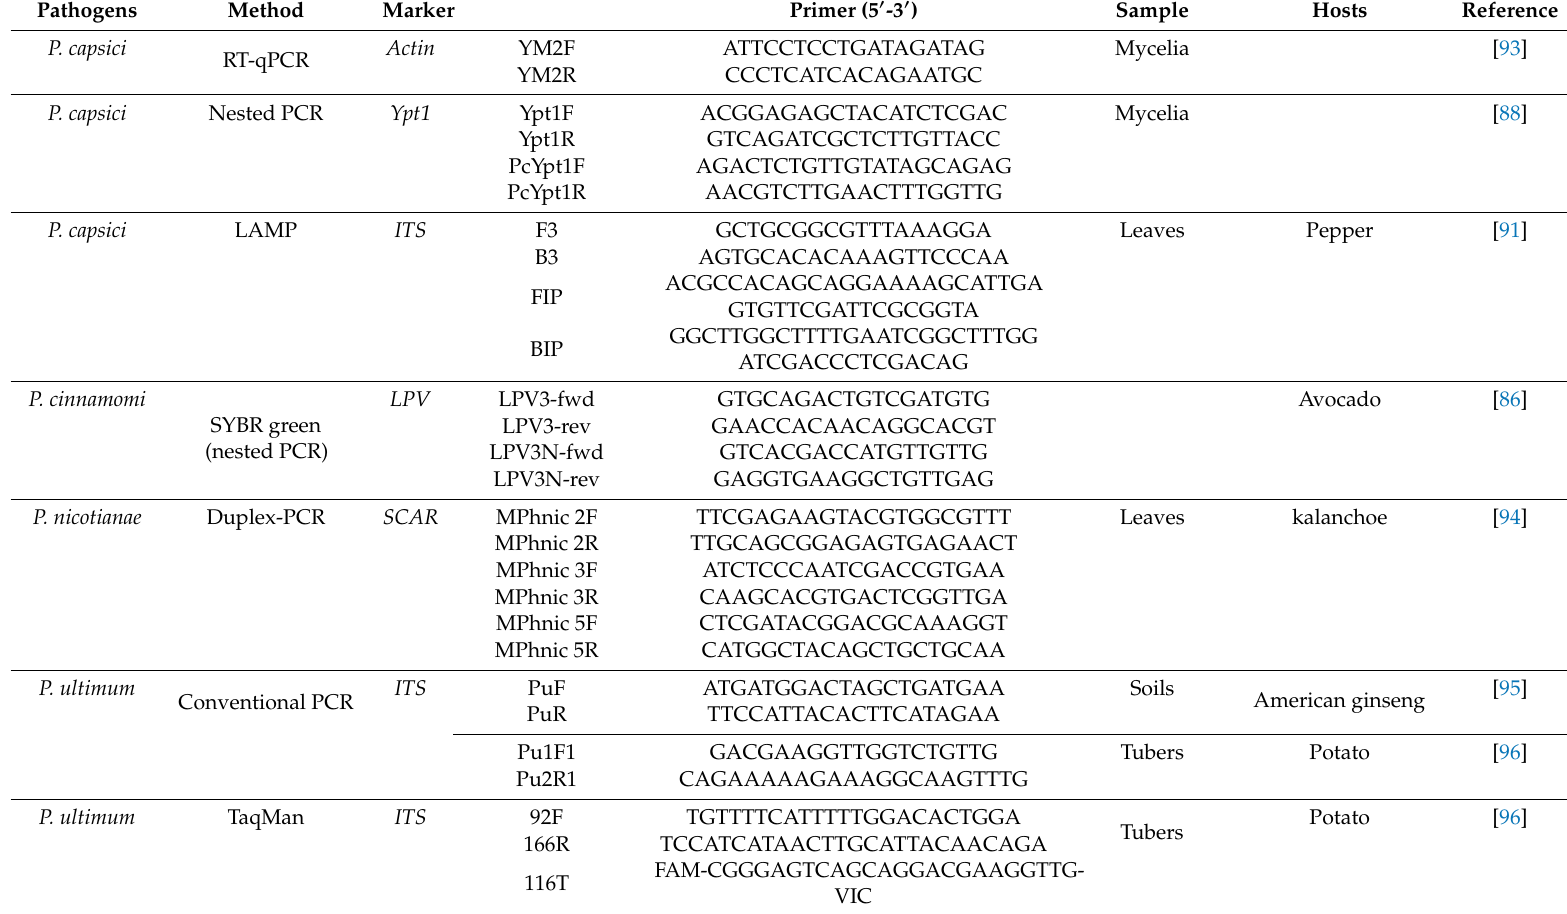
Table 4. Main techniques used for detecting